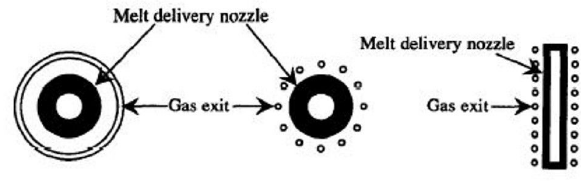
Figure 1: Molten metal break up mechanism [31].